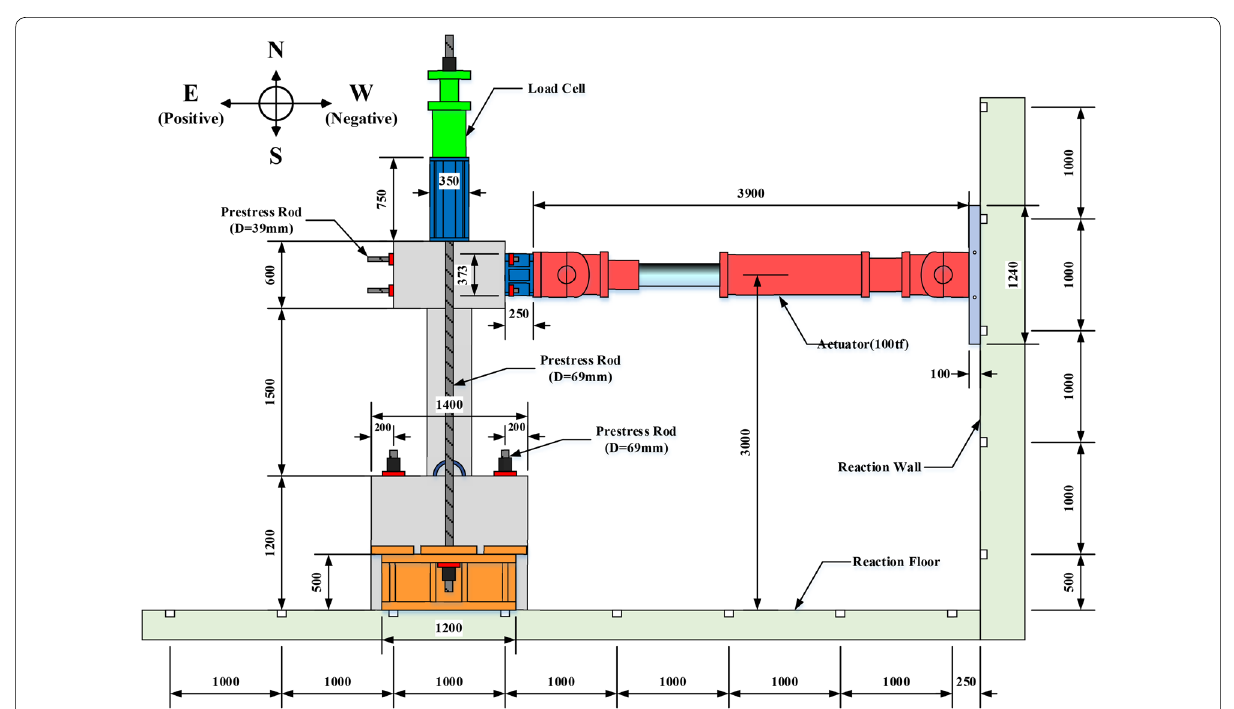
Fig. 4 Applied loading system for the cantilever beam specimens in this work.